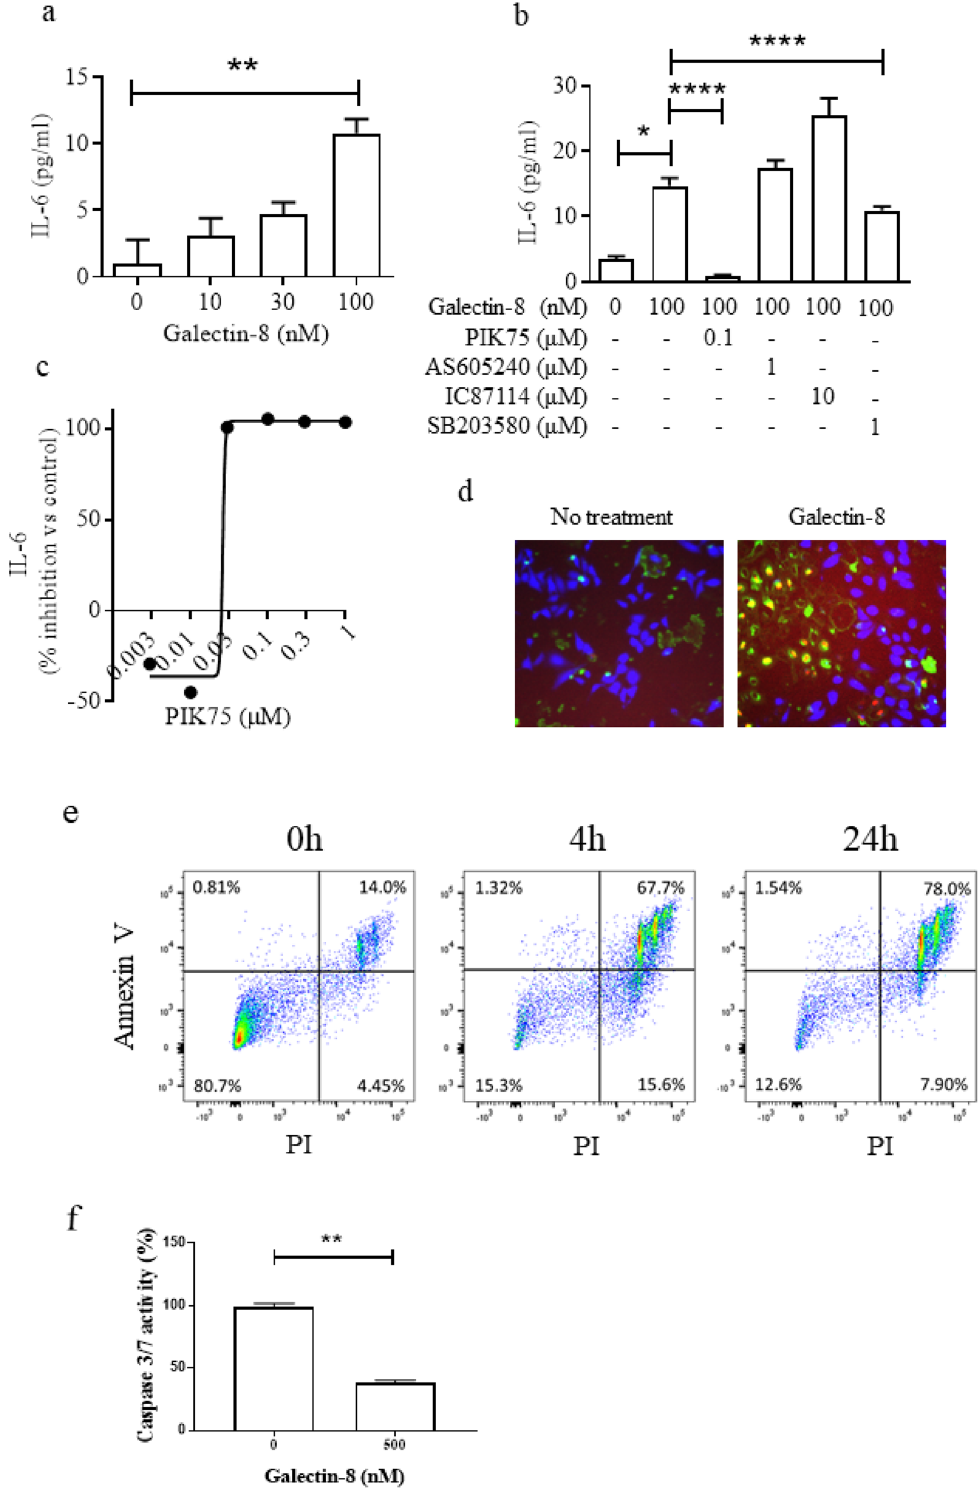
Figure 4. Soluble galectin-8 induces inflammation and apoptosis in BEAS-2B cells. ( a ) Recombinant galectin-8 induced IL-6 protein expression in supernatant from BEAS-2B cells, quantified by ELISA (n = 3), ( b ) Inhibition of galectin-8-induced IL-6 release from BEAS-2B cells by PI3K isoform and p38 MAPK inhibitor; (n = 3), ( c ) Inhibition of galectin-8-induced IL-6 release from BEAS-2B cells by the pan-PI3K inhibitor PIK75 (n = 3), ( d ) Detection of apoptosis in BEAS-2B cells treated with 500 nM recombinant human galectin-8; representative images from 3 independent experiments; Blue = live cells, Green + / Red − = early apoptotic cells, Green + /Red + = late apoptotic cells or non-apoptotic cells. ( e ) Flowcytometry analysis for apoptosis in BEAS-2B cells treated with 500 nM recombinant human galectin-8. ( f ) Caspase 3/7 activity of BEAS-2B cells treated with 500 nM recombinant human galectin-8. (n = 3). * P < 0.05, ** P < 0.01, **** P <